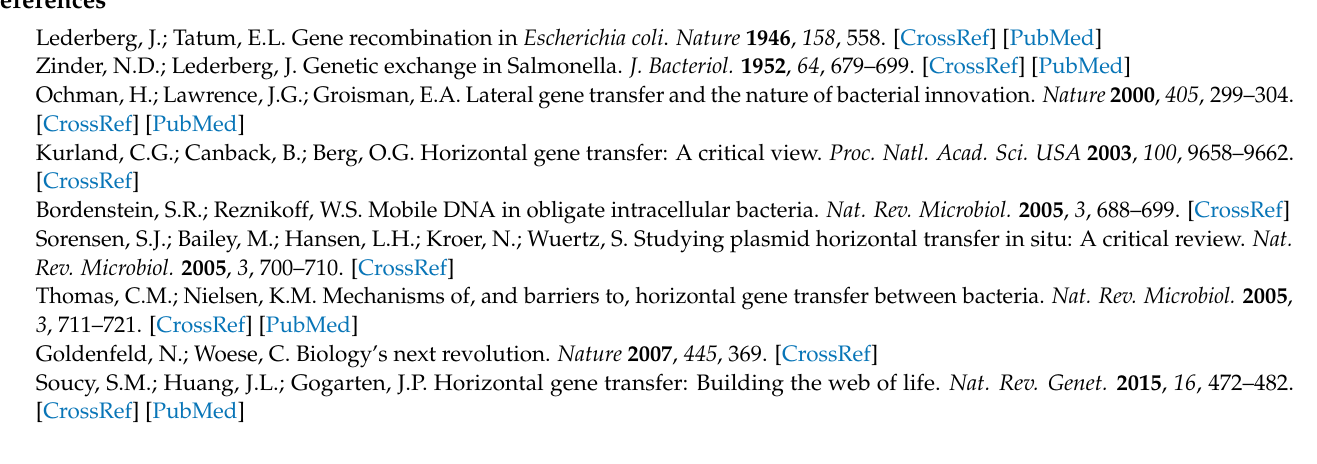
Sampling timeline, Table S2: Assembly details, Table S3: Phage content details, Table S4: ICE and IME content